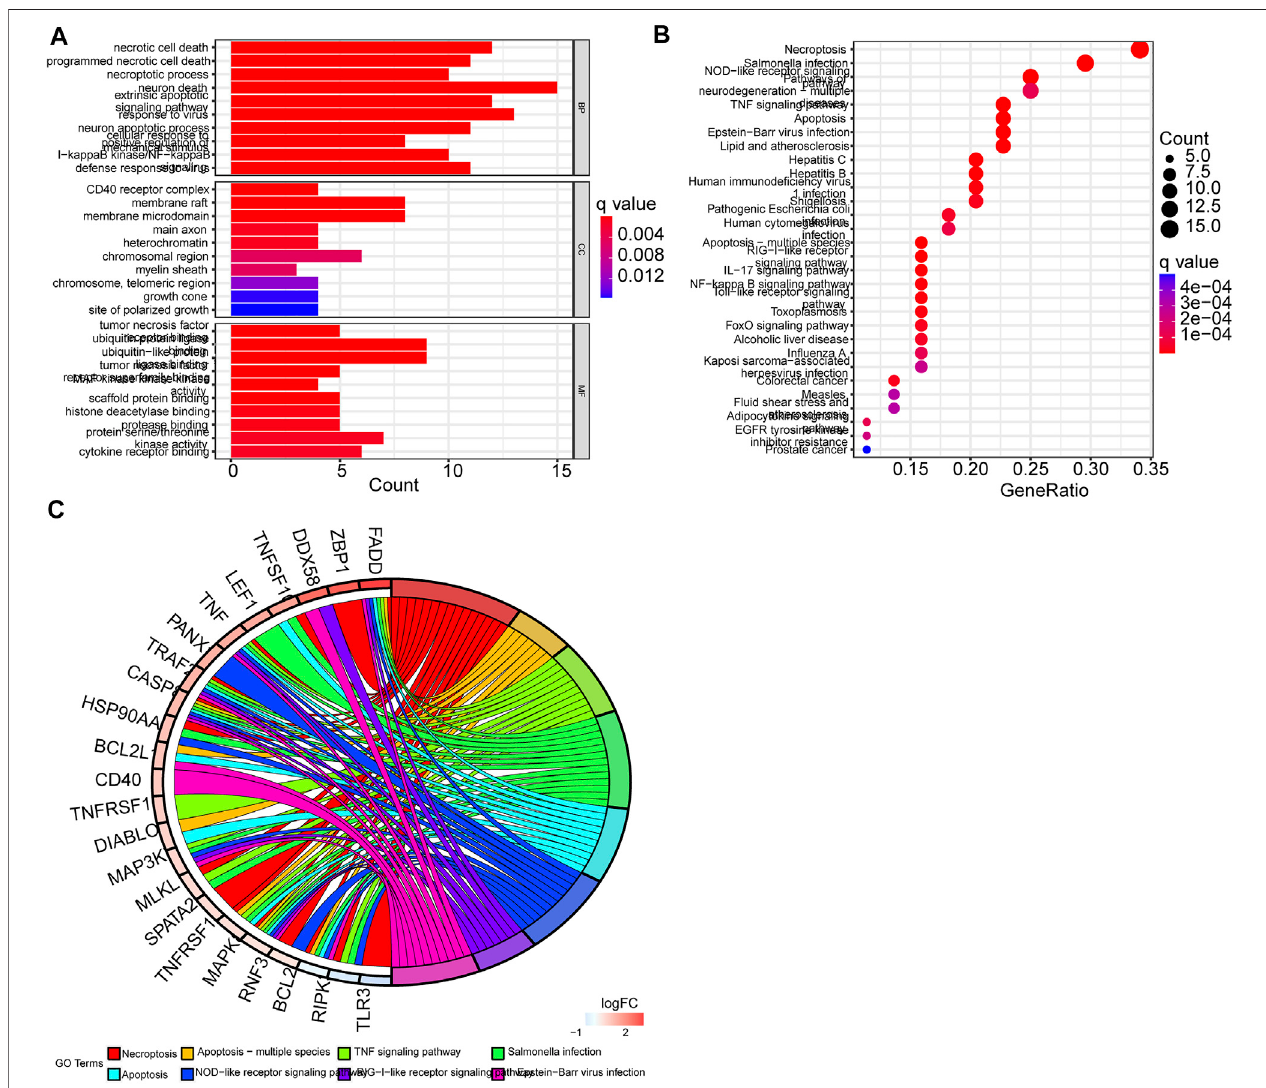
FIGURE3| Functionalanalysisofdifferentiallyexpressedgenes(DEGs). (A) GOenrichmentbarplot(longerbarsindicatemoreenrichedgenes,andrednessmeans the differences between the low-risk and the high-risk groups). (B) KEGG pathway bubble graph (bigger bubbles mean more enriched genes, and redness means the differencesbetweenthelow-riskandthehigh-riskgroups;q-valueswereadjusted p -values). (C) CircularplotofKEGGpathways.Left:Downregulationgeneexpression is indicated by green color and upregulation gene expression by red color. Right: Genes are linked via color ribbons to their function ( p < 0.05 for all).